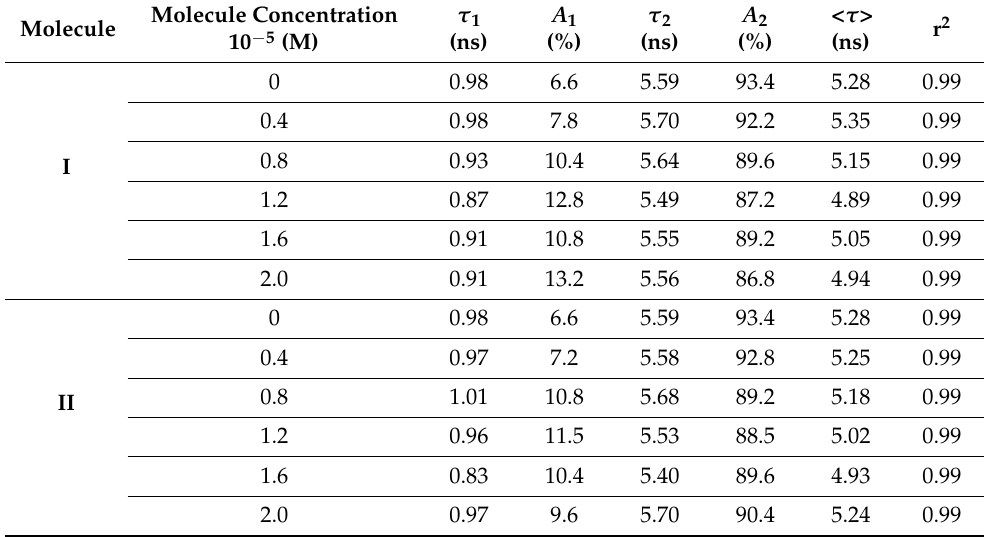
Table 4. BSA fluorescence lifetimes as a function of I and II concentration at room